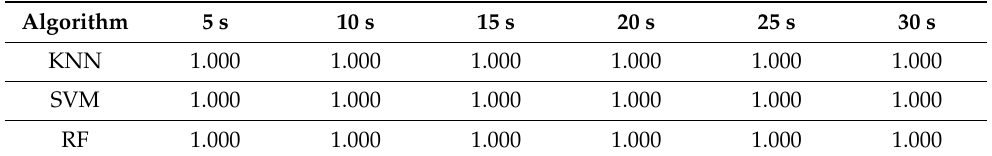
Table 9. Classification accuracy of SVM, RF, and KNN algorithm models using different slice time data of the direct expiratory